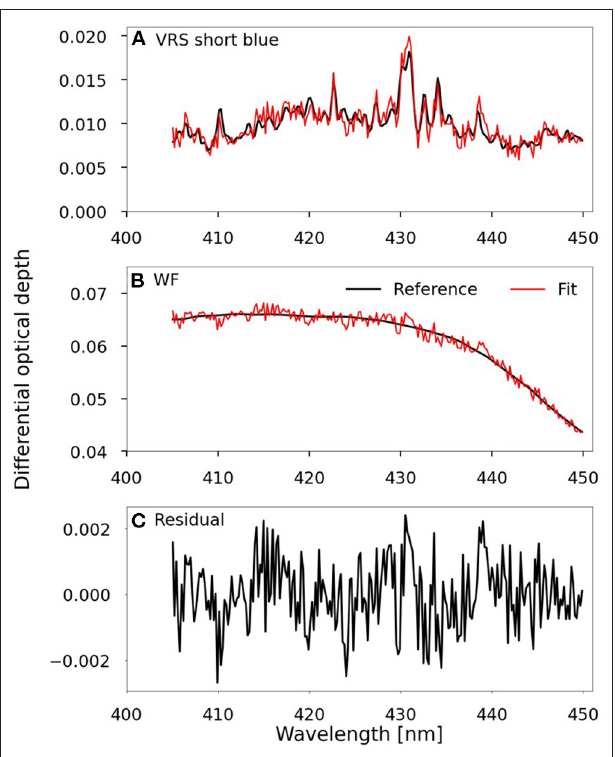
FIGURE 3 | Differential optical depth for (A) VRS, (B) other oceanic parameters (oceanic weighting function - WF) and (C) overall fit residual of the spectral fit of TROPOMI TOA radiances using DOAS for the short-blue (405–450 nm) wavelength range for one pixel measured on 11 May 2018 at 16:02:37, 29.09 ◦ W, 32.12 ◦ S, at 59.56 ◦ SZA. For plots (A,B) , the black line shows as reference the differential cross section multiplied by the retrieval